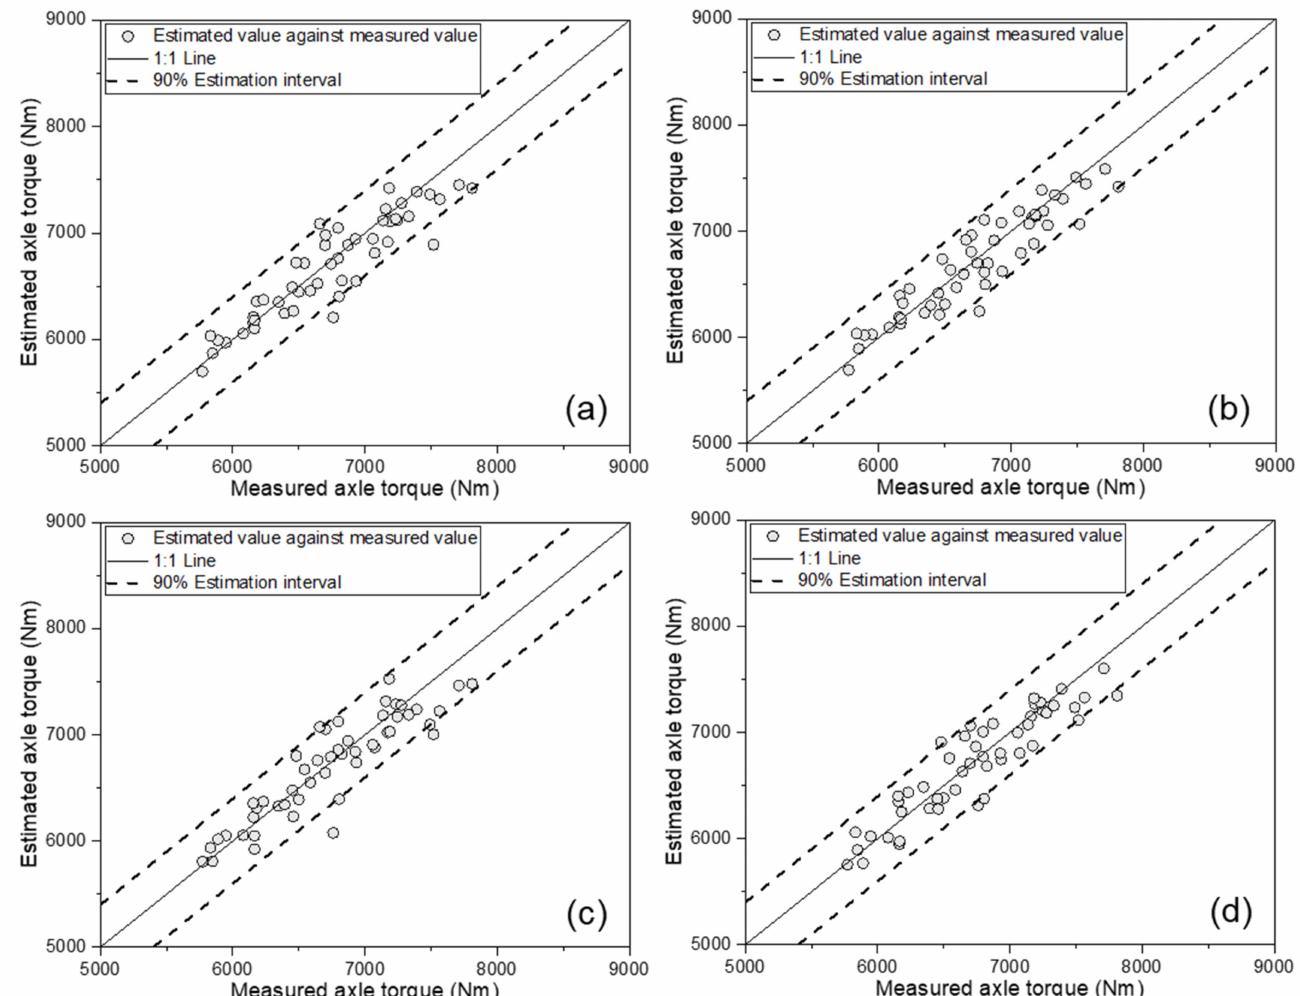
Figure 7. Results of ANN-based axle torque estimation model validation, comparing estimated values against measured axle torque: ( a ) as a function of the engine parameters; ( b ) as a function of the engine parameters and major tractor parameters; ( c ) as a function of the engine parameters and soil physical properties; and ( d ) as a function of the engine parameters, major tractor parameters, and soil physical